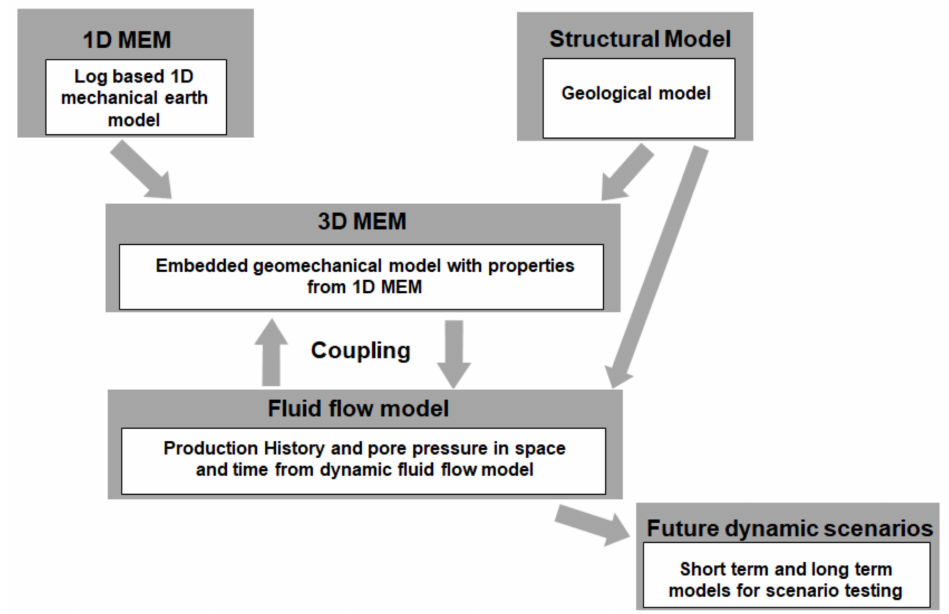
Figure 1. Flowchart illustrating the complete modeling workflow.